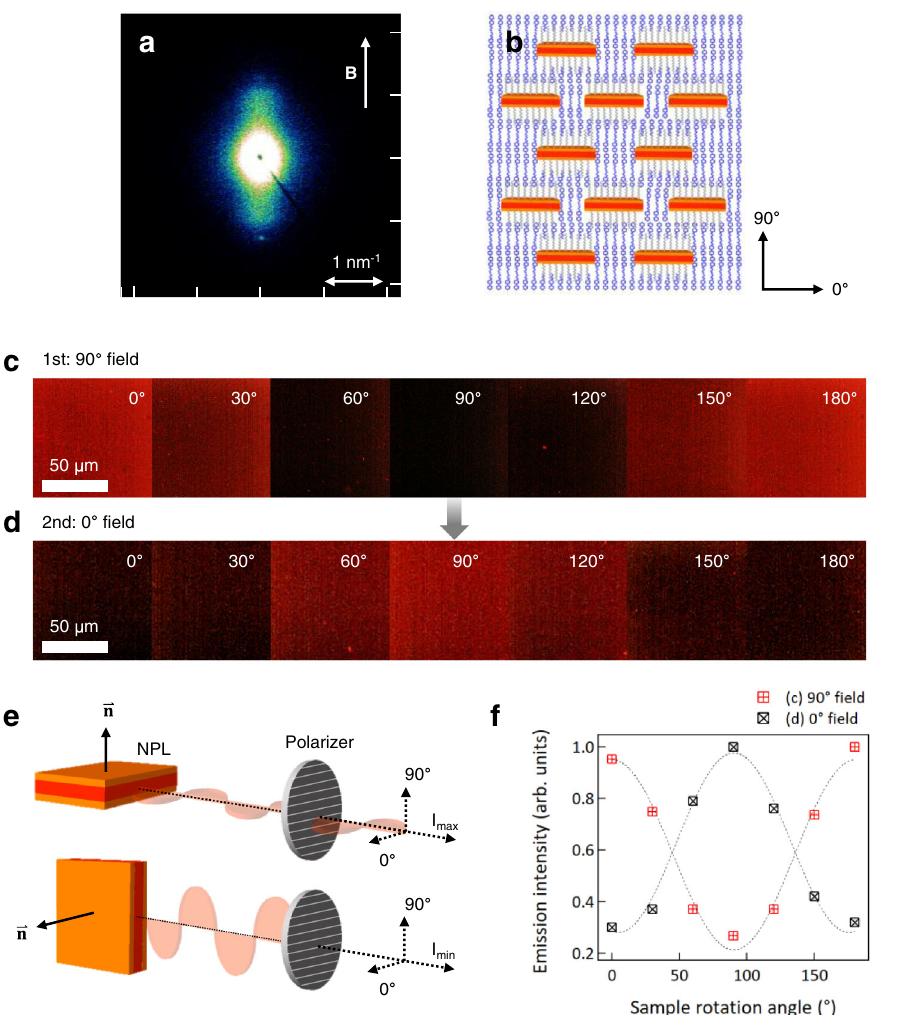
Fig. 5 Dynamic alignment of CdSe/ZnS core/shell NPLs in PNBCB/6OCB and the polarized emission characteristics. a SAXS pattern of NPL/PNBCB/ 6OCB composites under fi eld of 5.8 T at 50 °C. b Schematic presentation illustrating CdSe/ZnS NPL dispersion and alignment in a smectic phase PNBCB/ 6OCB matrix. c , d FM images of a fi eld-aligned NPL/PNBCB/6OCB fi lm as a function of the sample rotation angle, c after alignment under 90° fi eld and ( d ) realignment under 0° fi eld. The polarizer axis in the emission pathway is always along 0°. e Schematic illustration for the case of ( c ), showing the origin of ! the bright and dark state according to the orientation of NPLs relative to the n axis. f Normalized emission intensity of the aligned NPL/PNBCB/6OCB composite fi lm as a function of the sample rotation angle, determined from the FM images shown in ( c ) and ( d